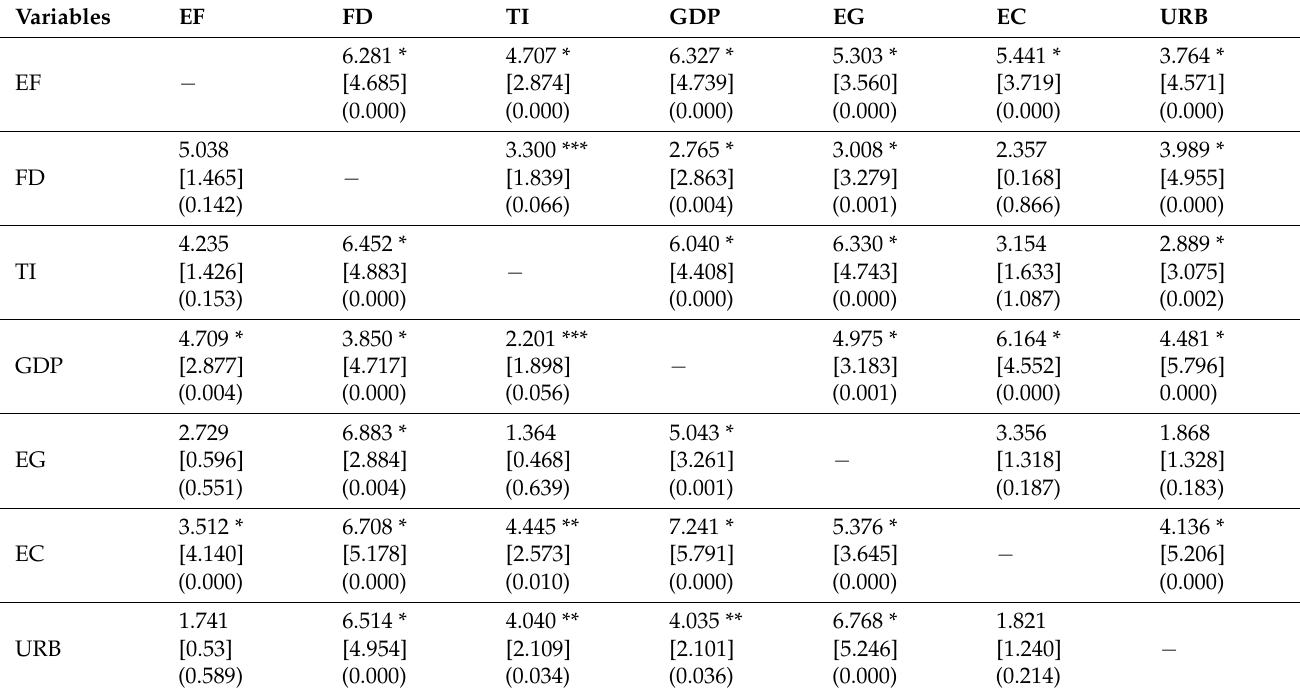
Table 8. The DH non-causality test